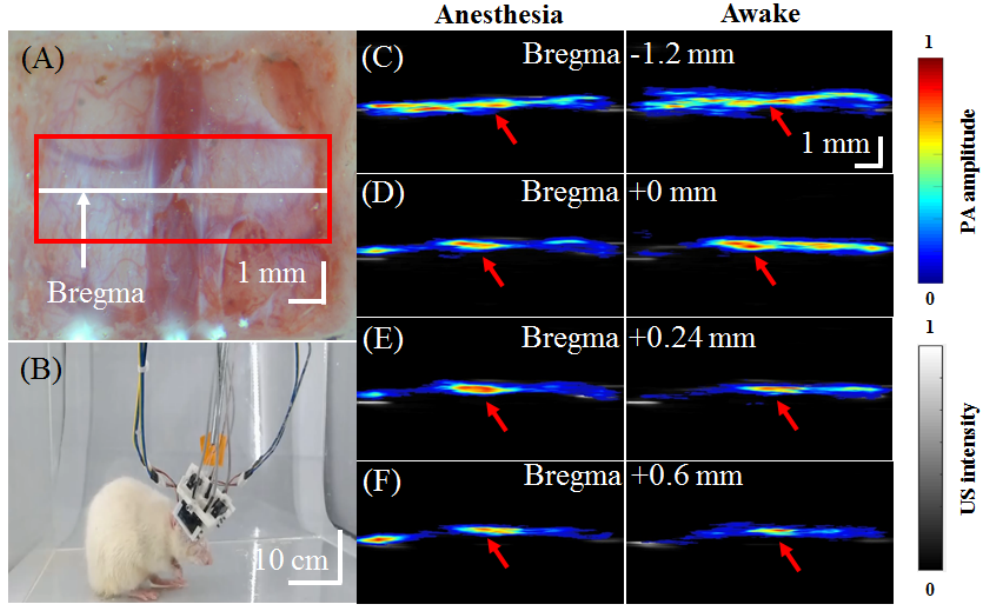
Figure 10. In vivo PA 800 B ‐ scan images of the cortical region of the rat brain at the positions of bregma − 1.2, 0, +0.24, +0.6 mm in anesthetized and awake rats. ( A ) Photograph of the rat brain after craniotomy for addition of the hmPAI system. ( B ) Representative movie depicting awake and freely moving experimental rats equipped with a wearable hmPAI system (Movie S3) for PA B ‐ scan imaging. ( C – F ) PA B ‐ scan images at bregma − 1.2, +0, +0.24, and +0.6 mm in anesthetized and awake rats. The experimental results show that the developed hmPAI system can successfully perform PA B ‐ scan imaging at different brain positions.